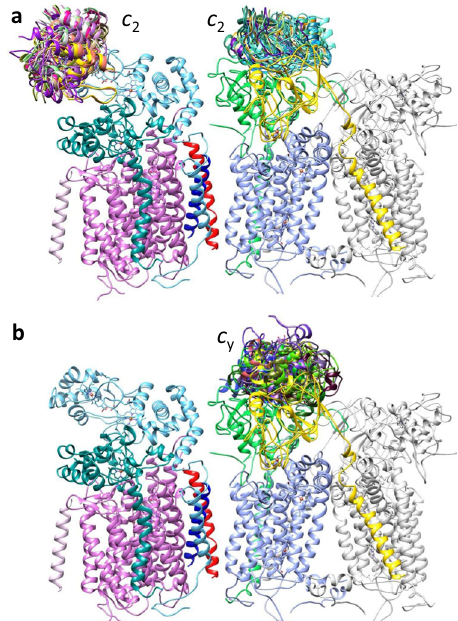
Fig. 4 Binding regions of cyt c 2 and cyt c y on CIII 2 CIV. The binding regions were de fi ned by XL-MS-guided docking, and the subunits of CIII 2 CIV are colored as in Fig. 2 except the monomer B of CIII 2 shown in light gray. Only the binding regions on monomer A are shown. a Cyt c 2 (PDB: 1C2N) was docked onto CIII 2 and CIV using PatchDock guided by DMTMM-generated XLs as distance restraints. This yielded one cluster of models on CIV and one per monomer of CIII 2 . b A model of cyt domain of c y , generated using P. denitri fi cans cyt c 552 structure (PDB: 3M97) as a template (RMSD between template and model: 0.2 Å) was docked on CIII 2 as in a , except that both DMTMM- and DSBU-generated XLs provided distance restraints. Two binding clusters for cyt domain of c y per monomer of CIII 2 were found. The two clusters are located behind each other on a side view but are clearly visible on top views (Supplementary Fig. 4h – j, labeled 1 and 2). Only cluster 1 that is closer to cyt c 1 and overlapping with the binding region of cyt c 2 is shown. In all cases, ten representative models are shown to visualize the clusters of binding models. No binding region for cyt c y on CIV could be de fi ned since no XL was found between the